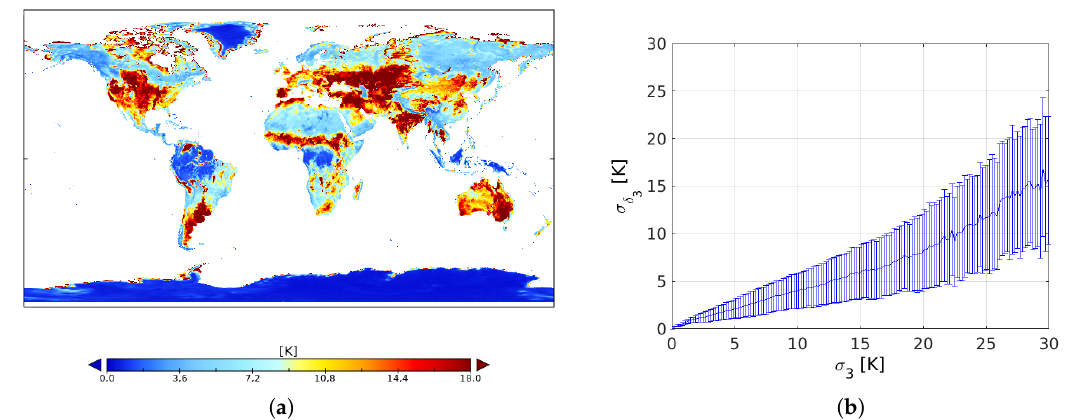
Figure 14. ( a ) Standard deviation of the SMAP measurements ( σ 3 ) for the analyzed period (June 2016–September 2017) NS ( b ) SMAP error standard deviation conditioned to SMAP TB standard